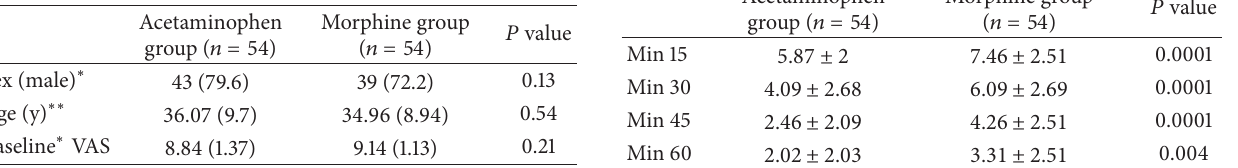
Table 1: Baseline characteristics of acetaminophen and morphine group participants.